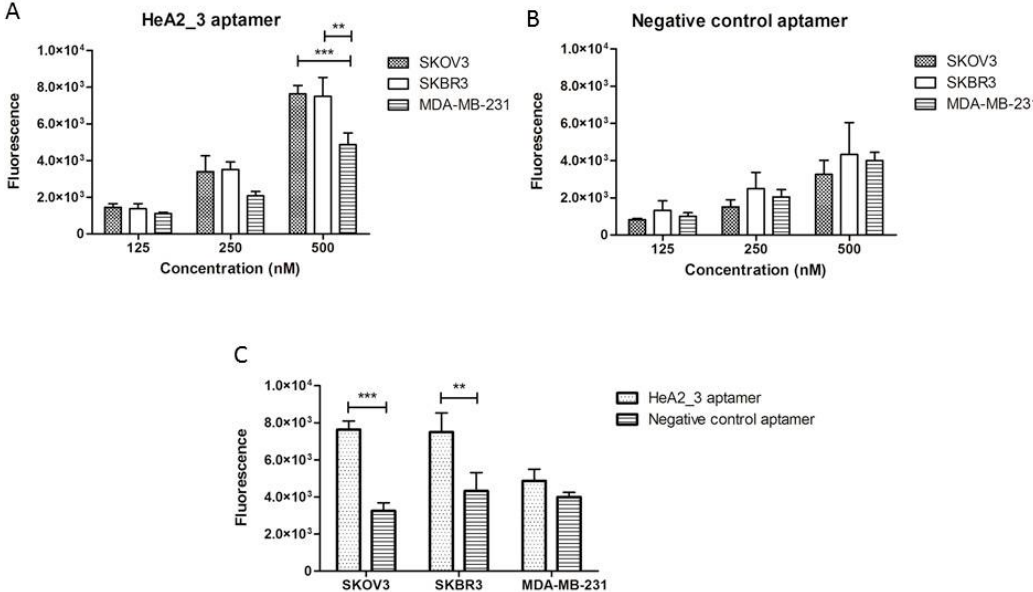
Figure 4. Flow cytometry analysis of aptamer specificity on cells with different HER2 expression levels. Bar graphs represent mean fluorescence of the cells incubated with three different concentrations (125, 250 and 500 nM) aptamer HeA2_3 ( A ) or negative control aptamer ( B ); ( C ) Bar graphs represent mean fluorescence of the cells incubated with 500 nM aptamer HeA2_3 or negative control aptamer. n ≥ 3 biological replicates, error bars represent SD, significance of differences was tested using the 2-way ANOVA test with ** p < 0.01 and *** p < 0.005.